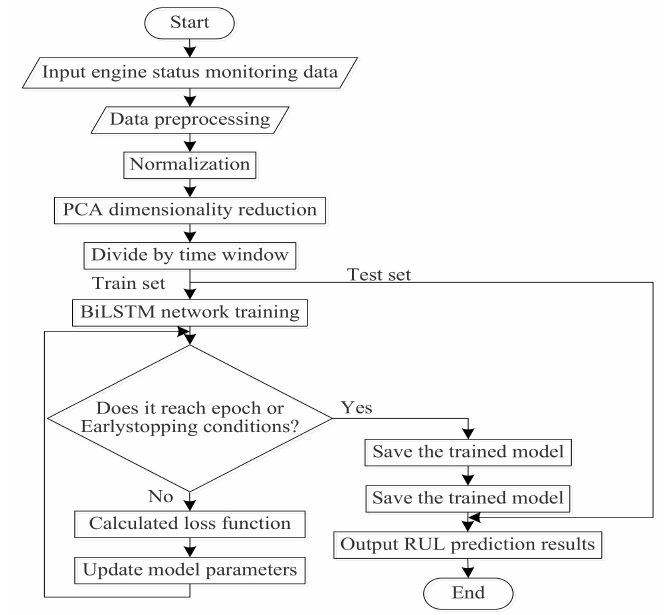
Figure 4. PCA–BLSTM model training flow